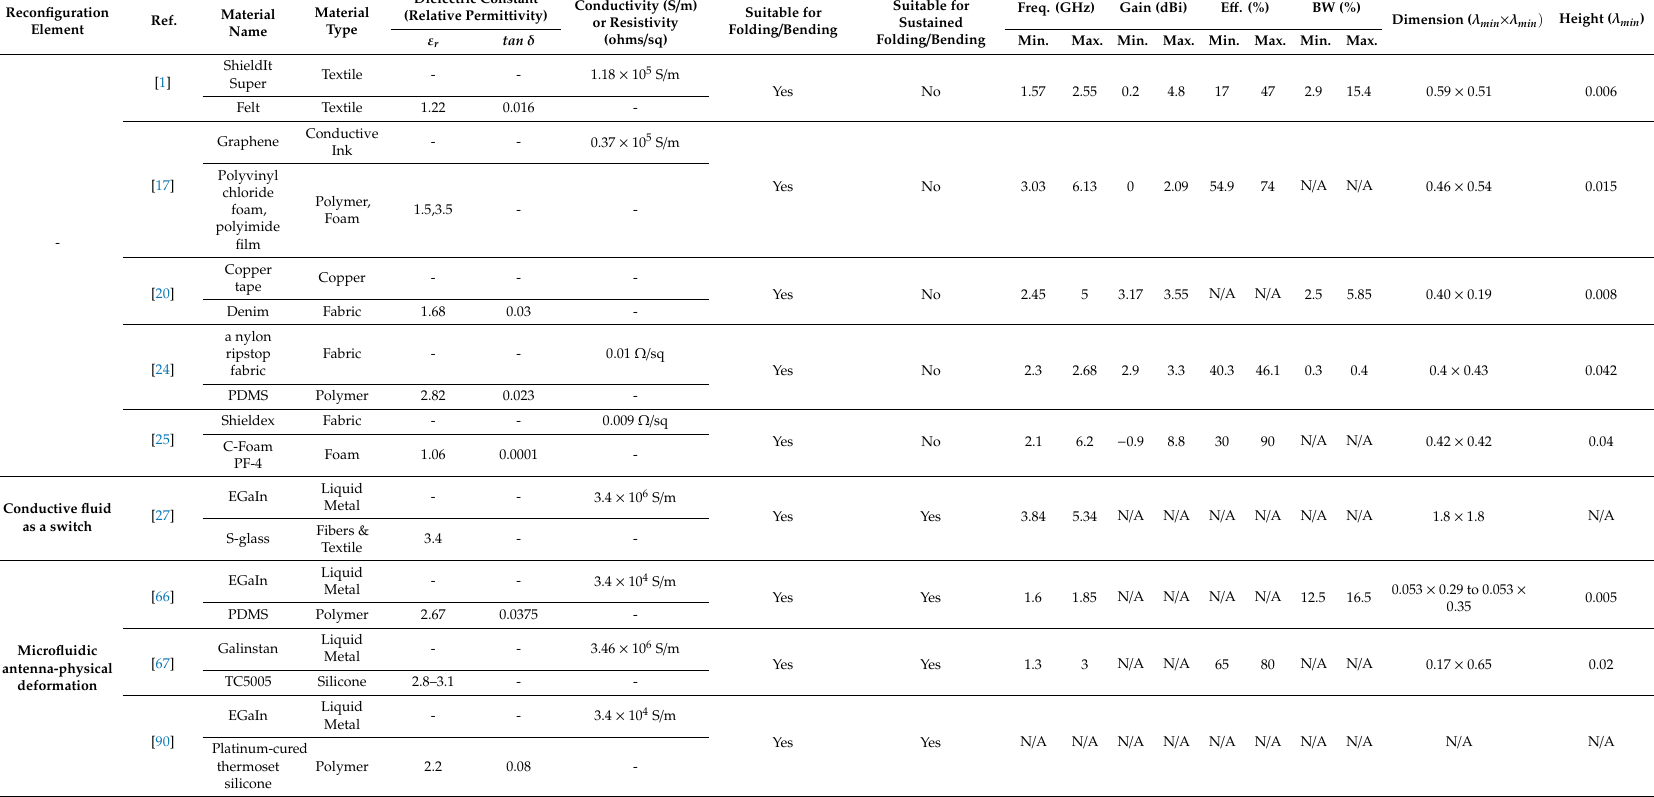
Table 3. Characteristics of materials with relevance to reconfiguration element used for flexible and conformal reconfigurable antennas along with corresponding